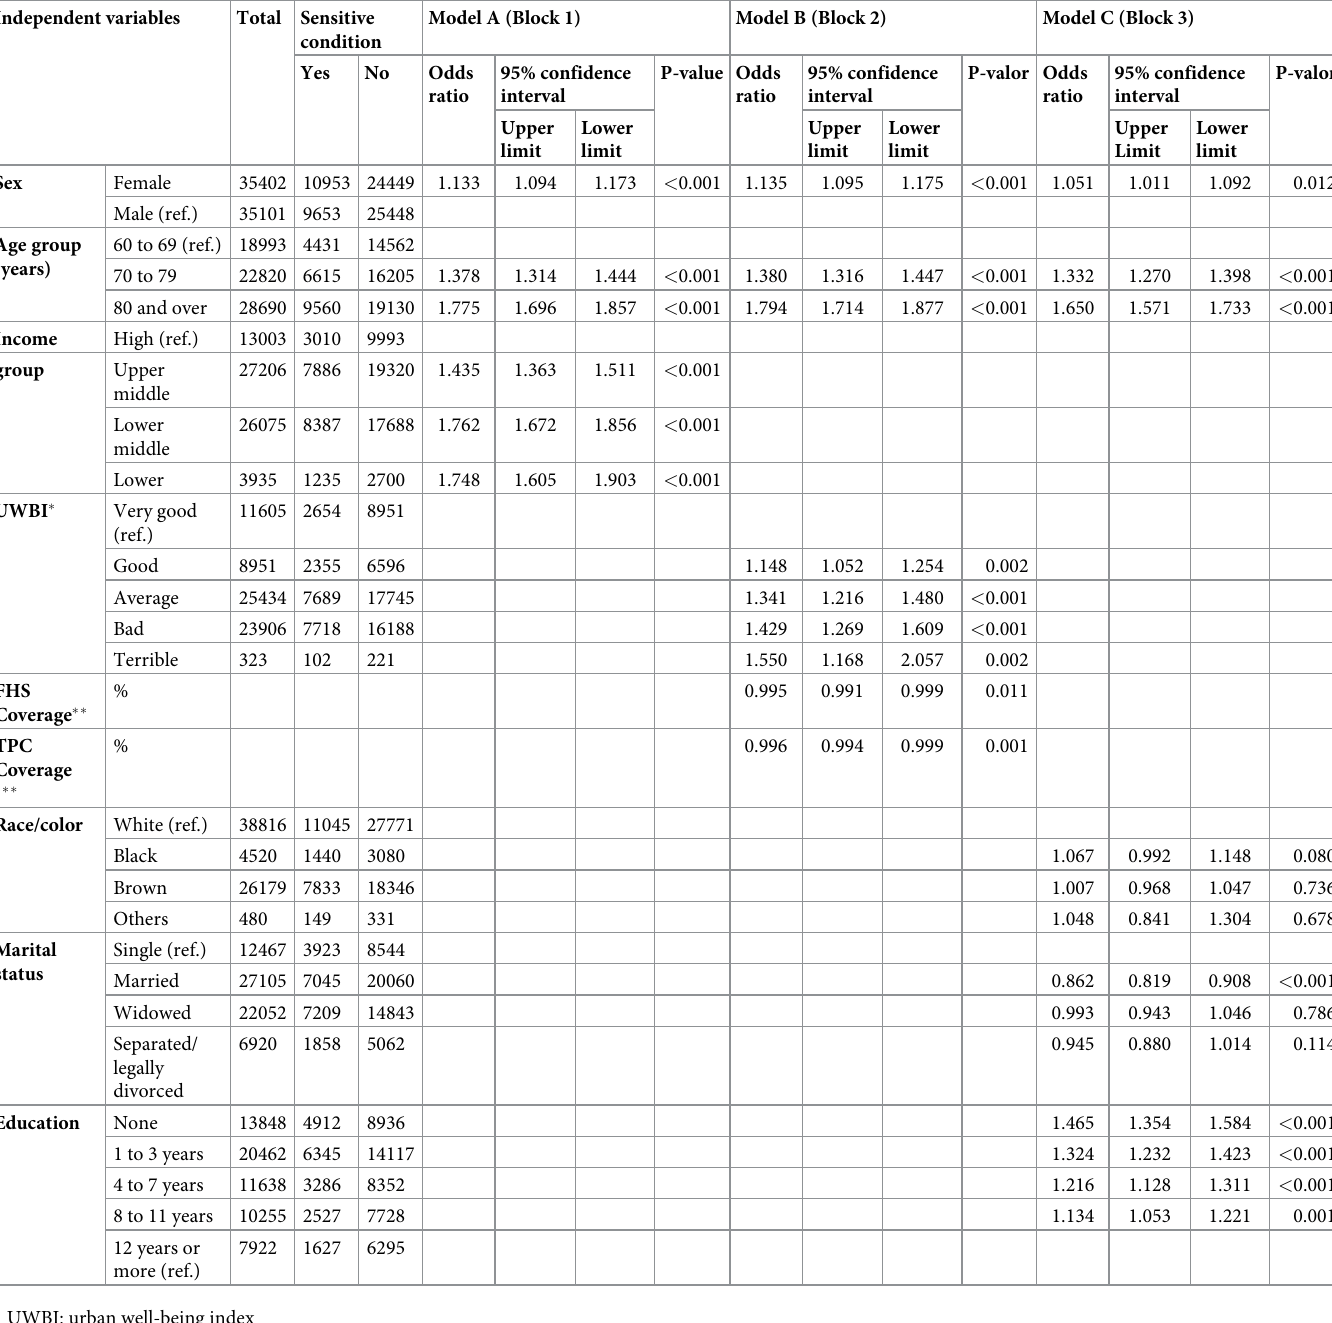
Table 2. Hierarchical model: Factors associated with deaths of the elderly from ambulatory care sensitive conditions, Distrito Federal, Brazil.